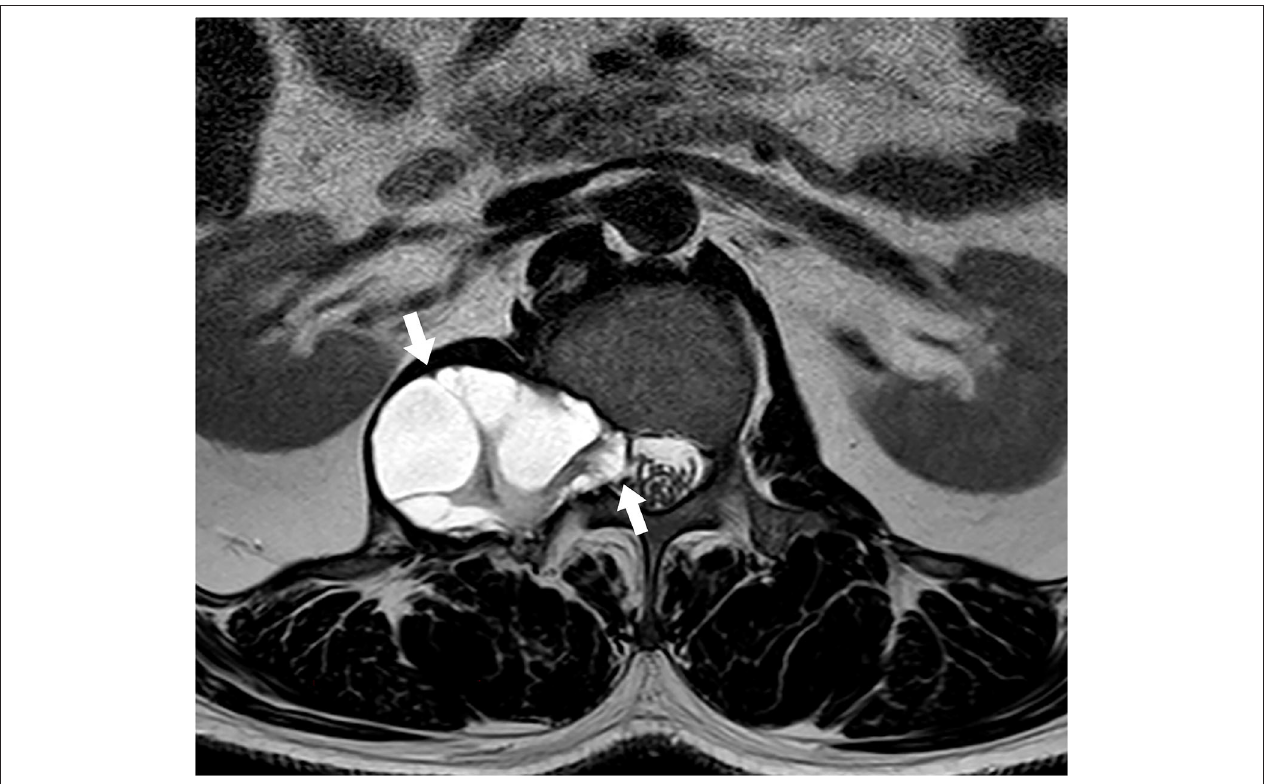
FIGURE 1 | MRI T2WI (axis image) showing hyperintense signal of an oval solid-cystic cavity at the right side of the vertebral body and across through the enlarged L1 ∼ L2 intervertebral foramen. Left arrow: The part outside of the spinal canal. Right arrow: The part passing through the intervertebral foramen and inside of the spinal